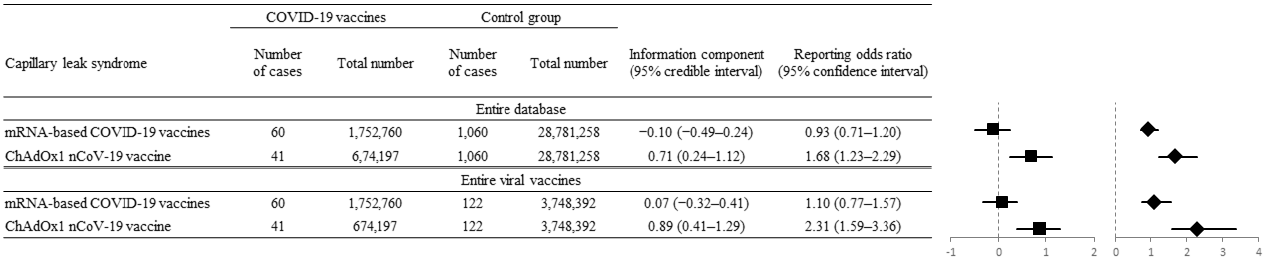
5 of 9 Figure 1. Time to onset of systemic capillary leak syndrome after vaccination with different types of COVID-19 vaccine. There was no significant difference observed among the vaccines. Considering IC 025 and ROR 025 , a significant potential signal of disproportionality of